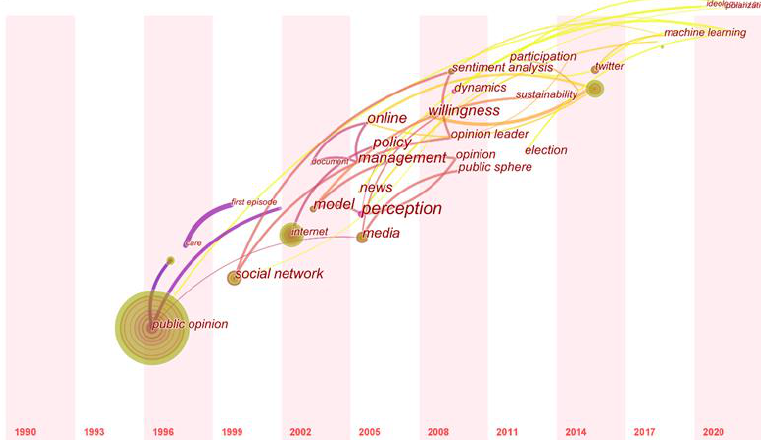
Figure 15. The keywords TimeZone view of NPO studies,1990 –